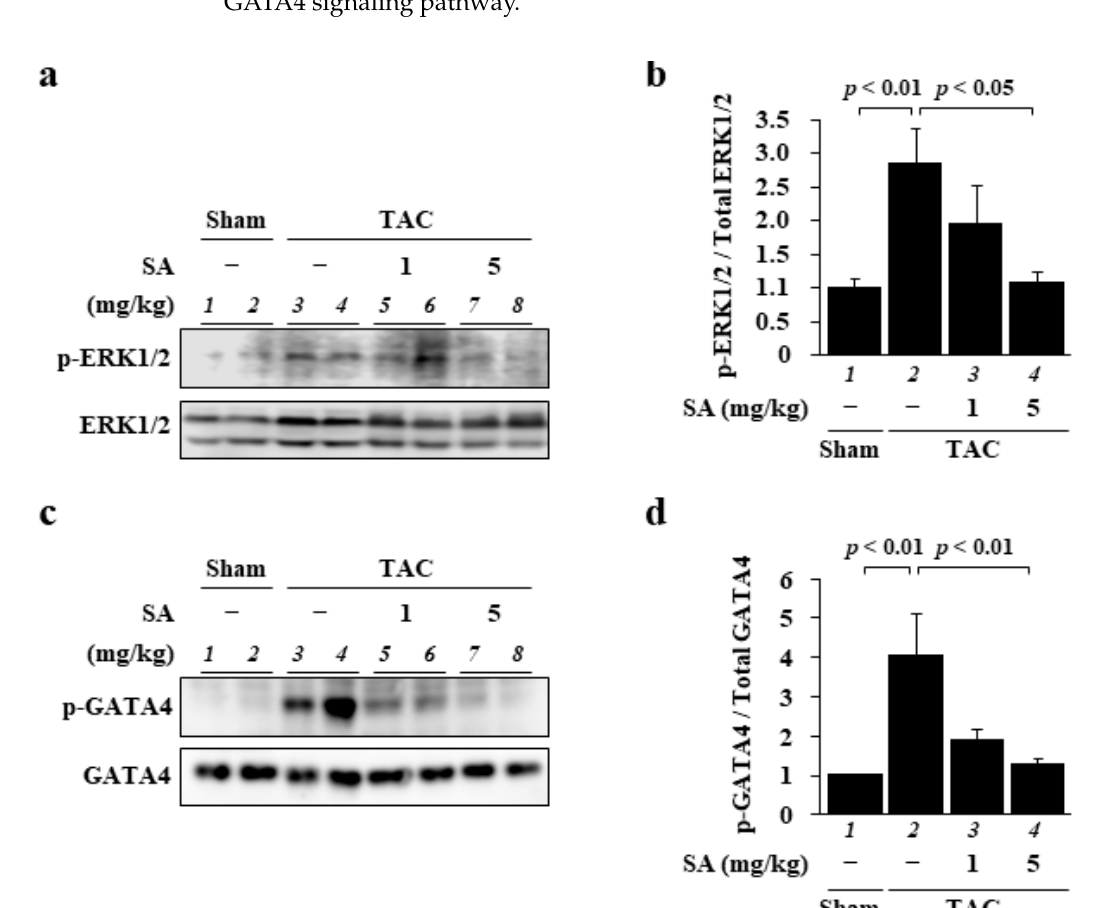
Figure 5. Sarpogrelate suppressed TAC-induced phosphorylation of ERK and GATA4. ( a , b ) WCL from mouse heart was subjected to Western blotting to assess the levels of phosphorylated ERK1/2 and total ERK. Representative Western blotting images are shown in ( a ) and quantified levels of phosphorylated and total ERK1/2 in ( b ). ( c , d ) NE fractions from mouse heart were subjected to Western blotting to assess phosphorylated GATA4 and total GATA4. Representative images of Western blotting are shown in ( c ) and quantified phosphorylated and total GATA4 levels in ( d ). All data are presented as the mean ± SEM of four individual experiments.